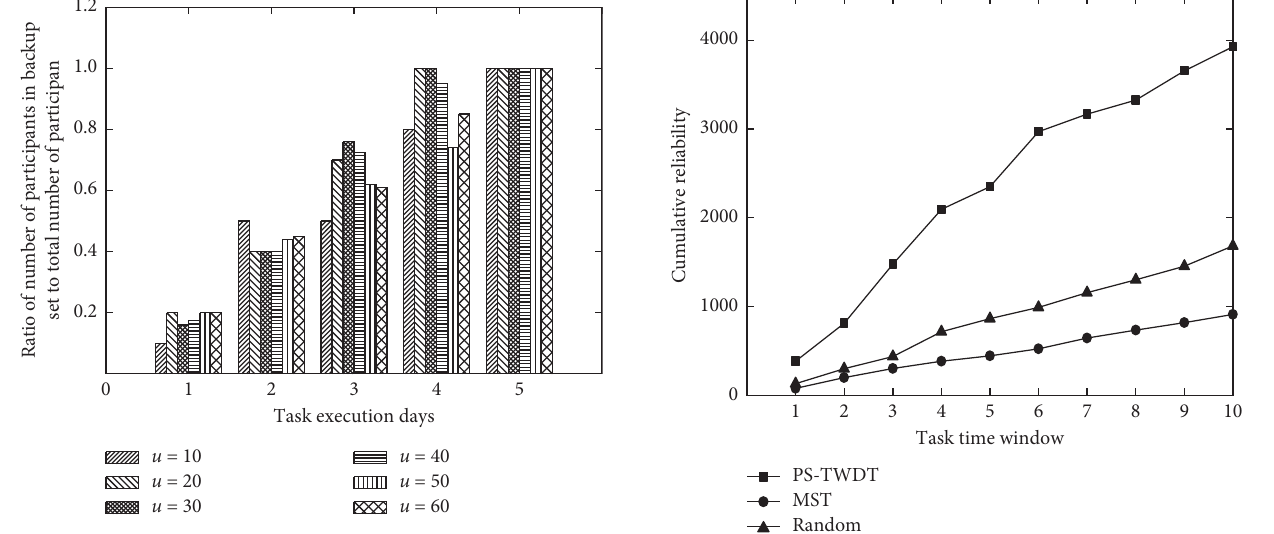
Figure 8: Cumulative data reliability.